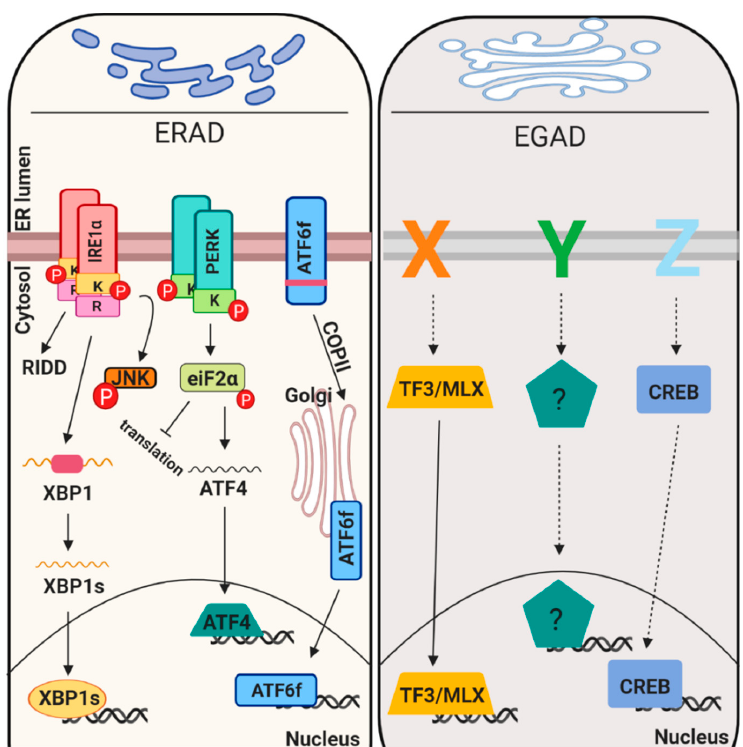
Figure 2. Organelle homeostasis imbalance signaling pathways. ER stress signaling (with the unfolded protein response (UPR) sensors IRE1, PERK and ATF6; left) and Golgi stress response (right). Left panel: unfolded protein accumulation is sense by three ER resident receptors: IRE1, PERK and ATF6. IRE1 activation imposes the induction of two different activities: kinasic and RNAsic